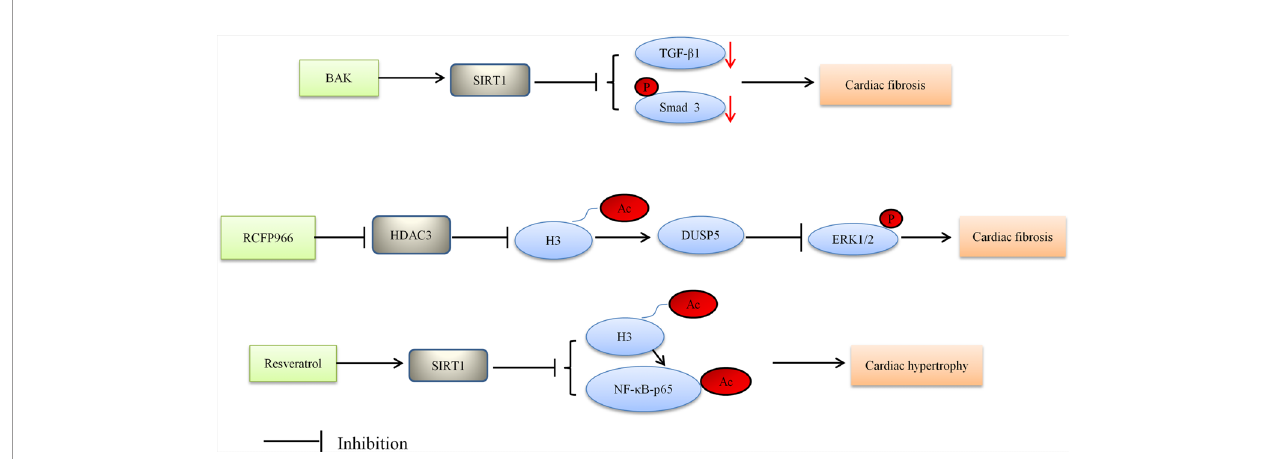
FIGURE 1 | Proposed model depicting regulation and the role of HDACs in cardiac fi brosis and hypertrophy, and thus alleviating DCM. BAK, bakuchiol; Ac, acetylation; P,